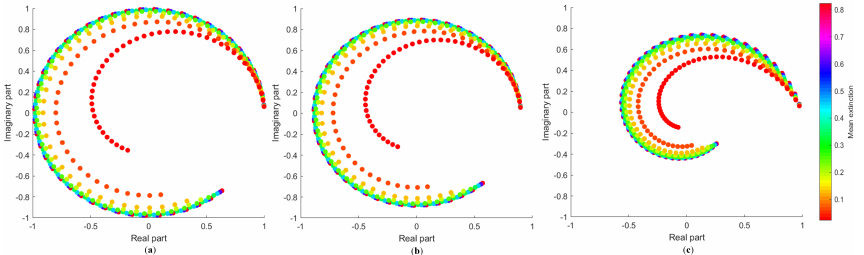
Figure 4. The LUTs of ( a ) RVoG model, ( b ) RVoG-vtd model (fixed α vt ) and ( c ) GRVoG-vtd model (fixed α g ) with different values of mean extinction coefficient κ e